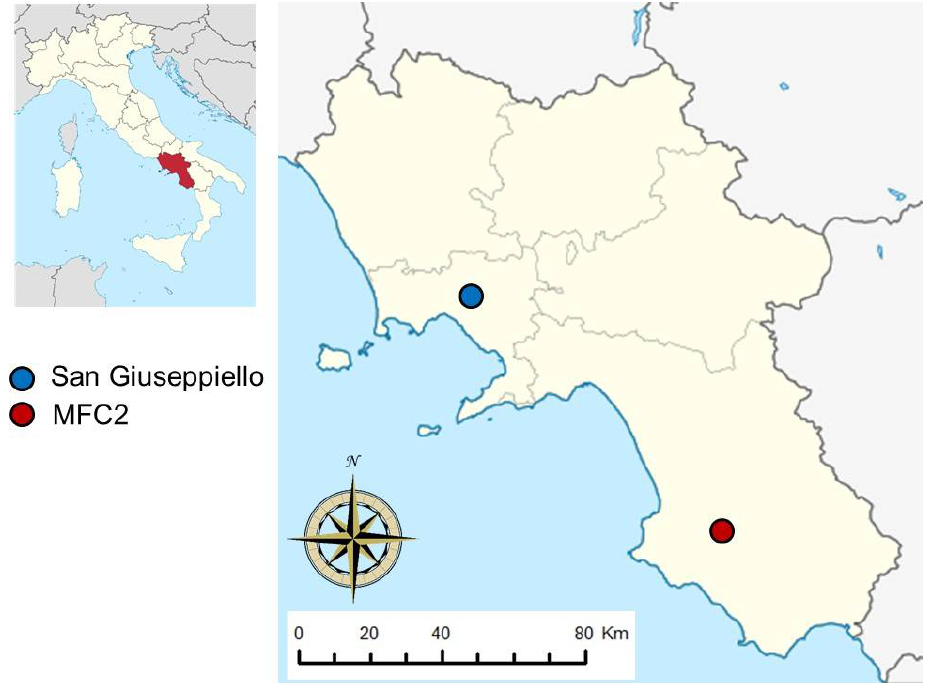
Figure 1. Map showing the region of Campania in southern Italy. The colored circles indicate the locations of the two experimental sites where some of the research activities discussed in this review paper are underway.